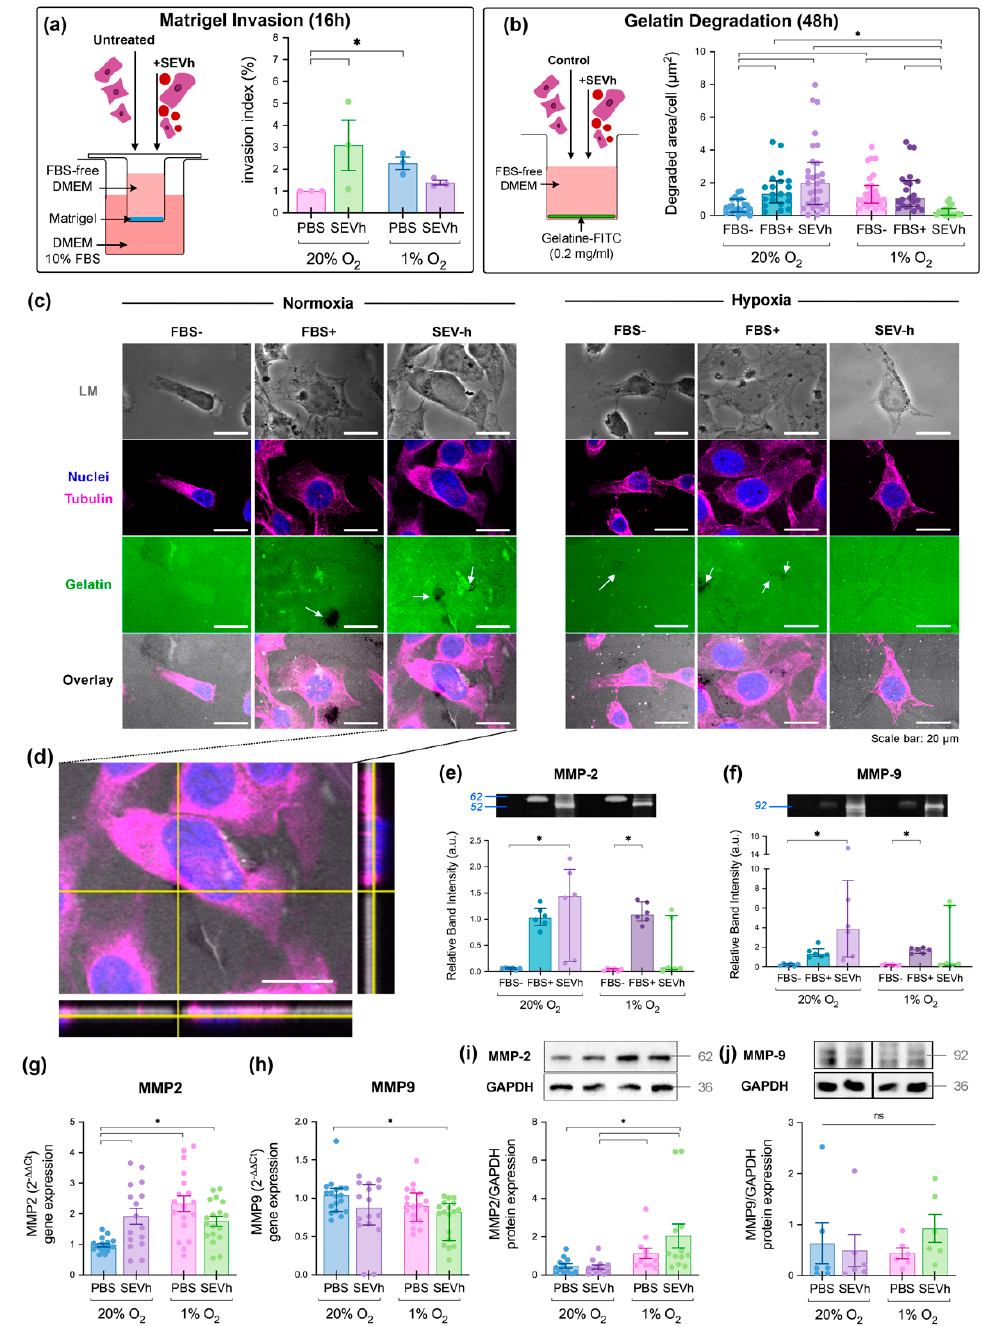
Figure 3. Normoxia triggers SEVh-mediated long-term invasion. ( a ) Experimental diagram of the Matrigel invasion chamber assay (left) and invasion index (%) after 16 h (median ± interquartile, right). ( b ) Experimental diagram of the fluorescent gelatin degradation assay (left) and comparison of the degraded area after 48 h (median ± interquartile, right). ( c ) Representative images of the gelatin degradation assay in light microscopy (LM) and fluorescent nuclei (DAPI, blue), tubulin, (AlexaFluor647, pink) and gelatin (0.2 mg/mL, fluorescein, green). Below, there are the merged images. Degradation spots in black are indicated by white arrows (scale bar: 20 µm). ( d ) Orthogonal view of normoxic, SEVh-treated cells with the degradation spot near the cellular body (scale bar: 20 µm). ( e , f ) Proteolytic activity from the gelatin degradation assay supernatant of ( e ) MMP-2 (mean ± SEM) and ( f ) MMP-9 (median ± interquartile). ( g , h ) Gene expression of ( g ) MMP2 (mean ± SEM) and ( h ) MMP9 (median ± interquartile) in MDA-MB-231 cells. ( i , j ) Protein expression of ( i ) MMP-2 (mean ± SD) and ( j ) MMP-9 (median ± interquartile). * p < 0.05.